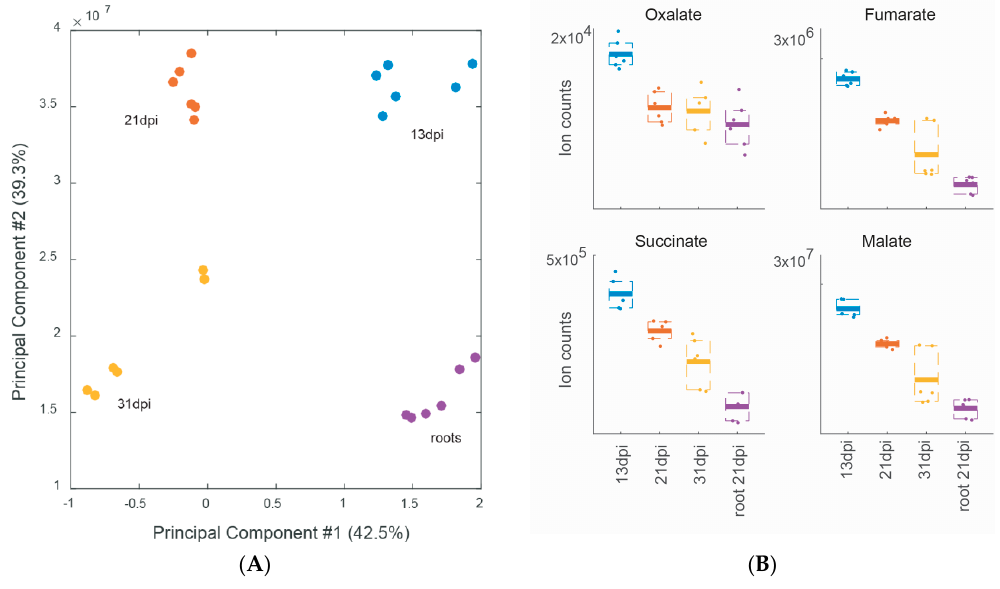
Figure 3. PCA of soybean wild-type nodules at different developmental stages: 13 dpi (blue), 21 dpi (red) and 31 dpi (yellow); root only material (purple); #: number ( A ). Three biological replicates were examined, each analyzed twice by non-targeted metabolomics; Differential accumulation of oxalate and C4-dicarboxylates ( B ). Table 2. Three clusters of B. diazoefficiens metabolites that show differential abundance during soybean nodule development (13, 21, 31 dpi).